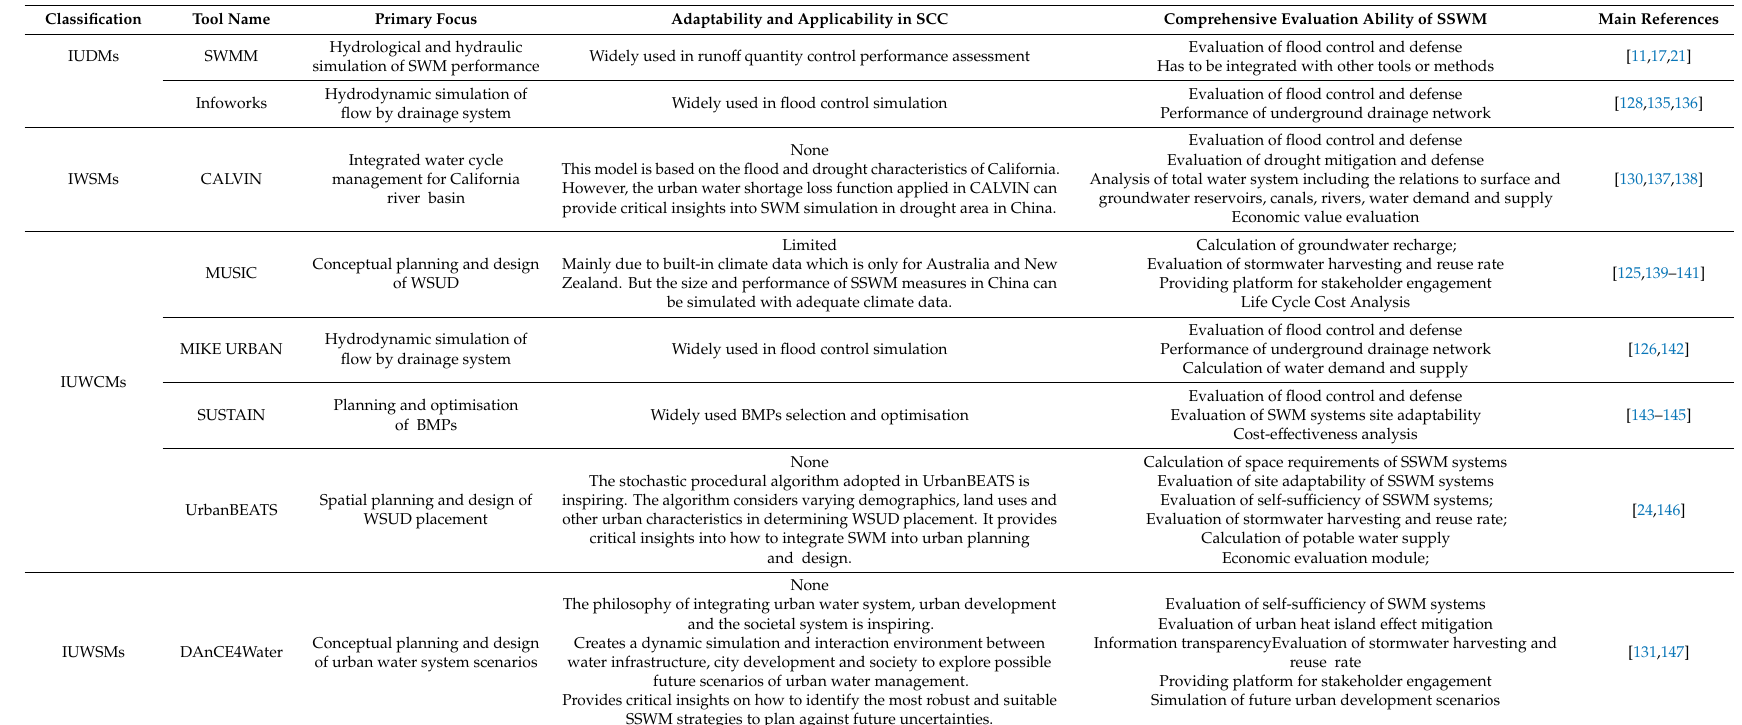
Table 3. Comparison of eight decision aid tools in assisting